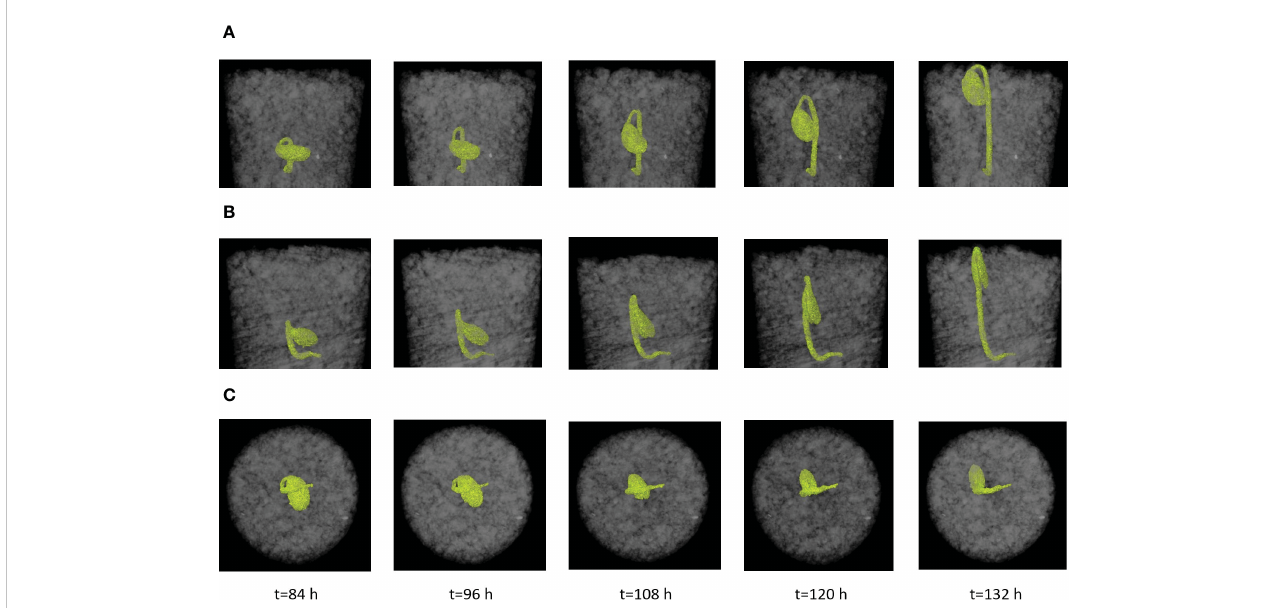
FIGURE 6 Time (t) lapse of a dark-grown soybean seedling in soil from CT images and morphological the characteristics of seedlings over time (Test No. 5). (A) X-Z view, the de fi nition of apical angle of hypocotyl. (B) Y-Z view, the de fi nition of cotyledon angle. (C) X-Y, the de fi nition of cotyledon pressure